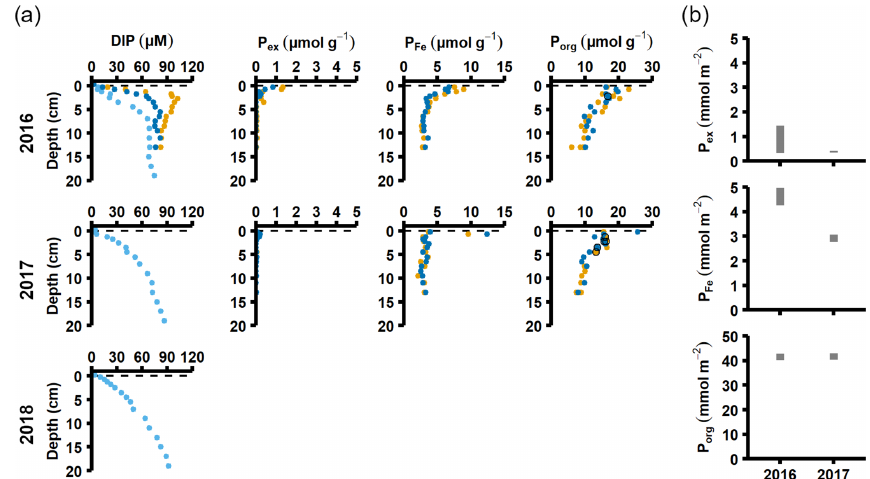
Figure 3. Pore water and sediment solid-phase data from station F. (a) Profiles of pore water DIP, solid-phase exchangeable or loosely- sorbed P (P ex ), easily reduced or reactive iron-bound P (P Fe ), and organic P (P org ). Profiles with light blue markers are from big sediment cores (inner diameter 9.9cm), and profiles with dark blue and orange markers are from replicate small sediment cores (inner diameter 6cm). Markers with black edges are missing data that have been replaced with average concentrations from the slices directly above and below (see